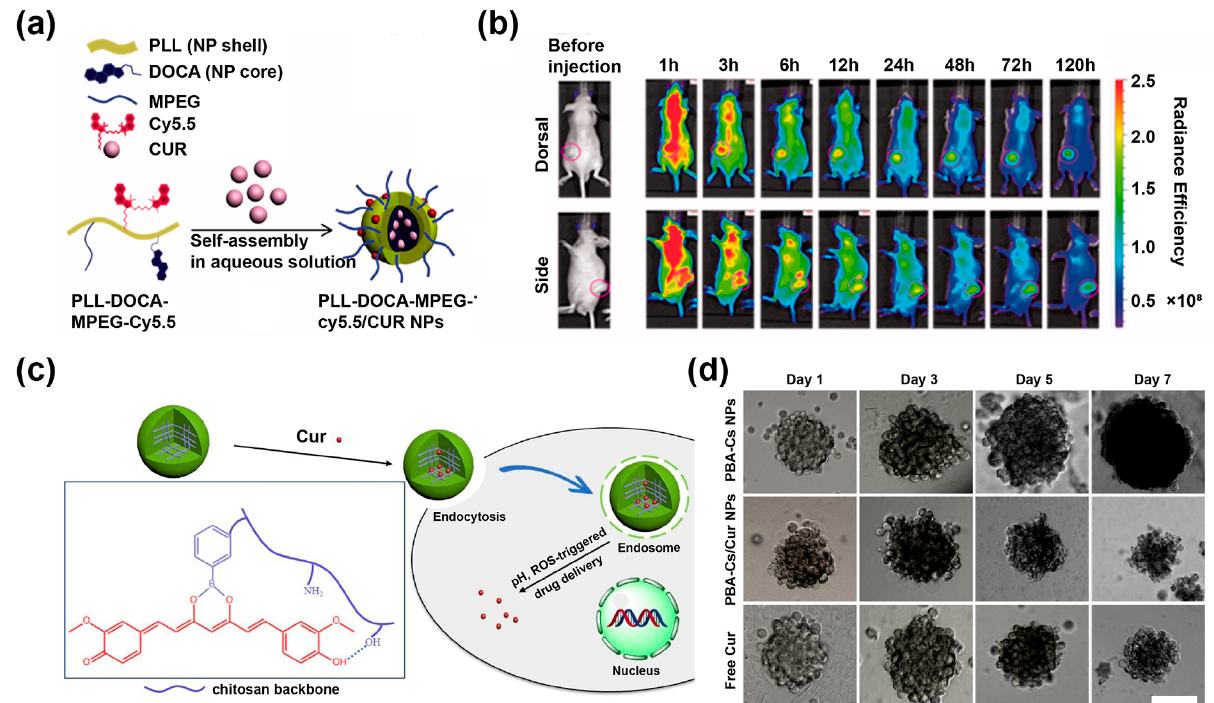
Figure 3. ( a ) Schematic diagram of the preparation of PLL-DOCA-MPEG-Cy5.5/Cur NPs. ( b ) In vivo whole-body near-infrared (NIR) fluorescence images of Hep3B tumor-bearing mouse models. PLL- DOCA-MPEG-Cy5.5/Cur NPs were injected via the lateral tail vein. Reproduced with permission from [43], Copyright 2018, Taylor & Francis. ( c ) Schematic illustration of the formation of PBA- Cs/Cur-NPs and pH/ROS-triggered Cur release. ( d ) Representative images of HepG2 MCTS treated with PBA-Cs NPs, PBA-Cs/Cur NPs and free Cur (Scale bar = 100 μ m). Reproduced with permission from [44], Copyright 2021, Elsevier.